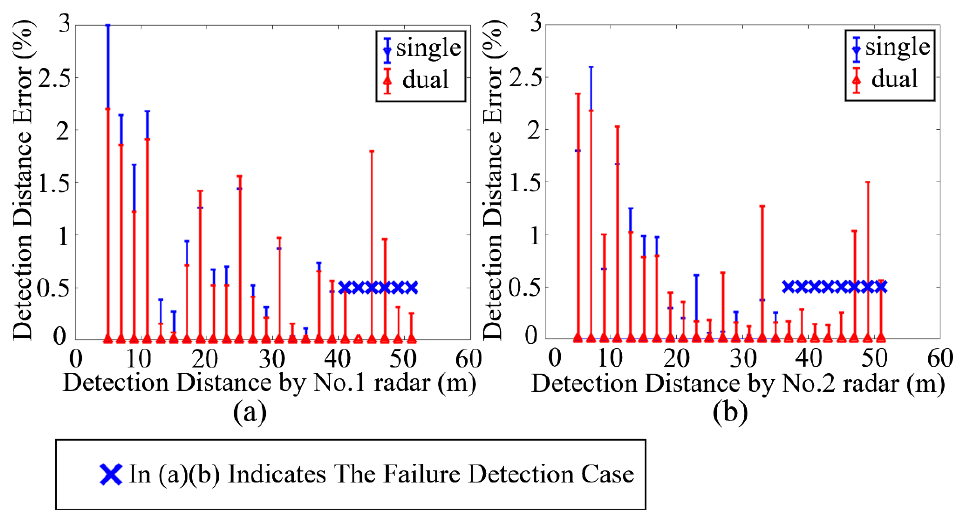
Figure 11. The summarization of the type-I experiment. ( a ) The detection errors of No.1 radar. ( b ) The detection errors of No.2 radar ( b ) The detection errors of No.2